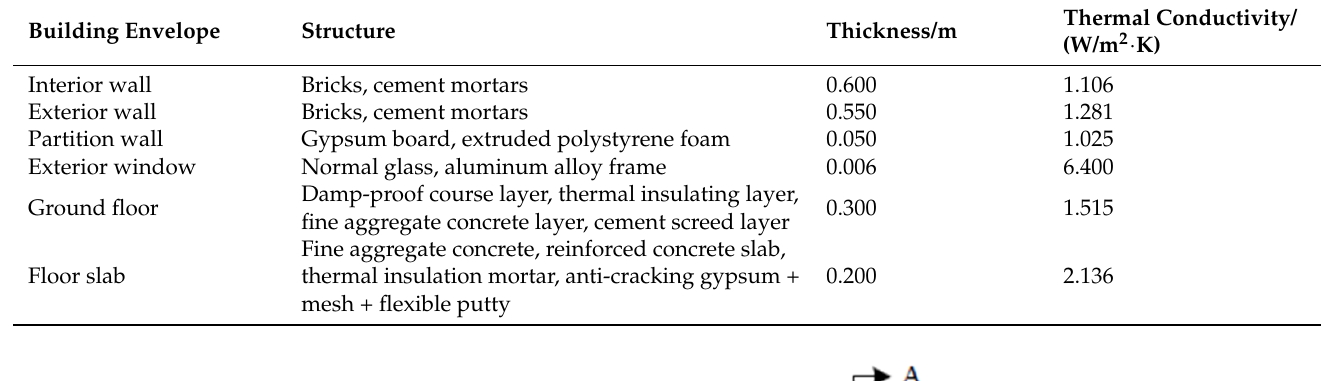
Figure 1. Laboratory floor plan. Table 1. Thermal parameters of the building envelope.